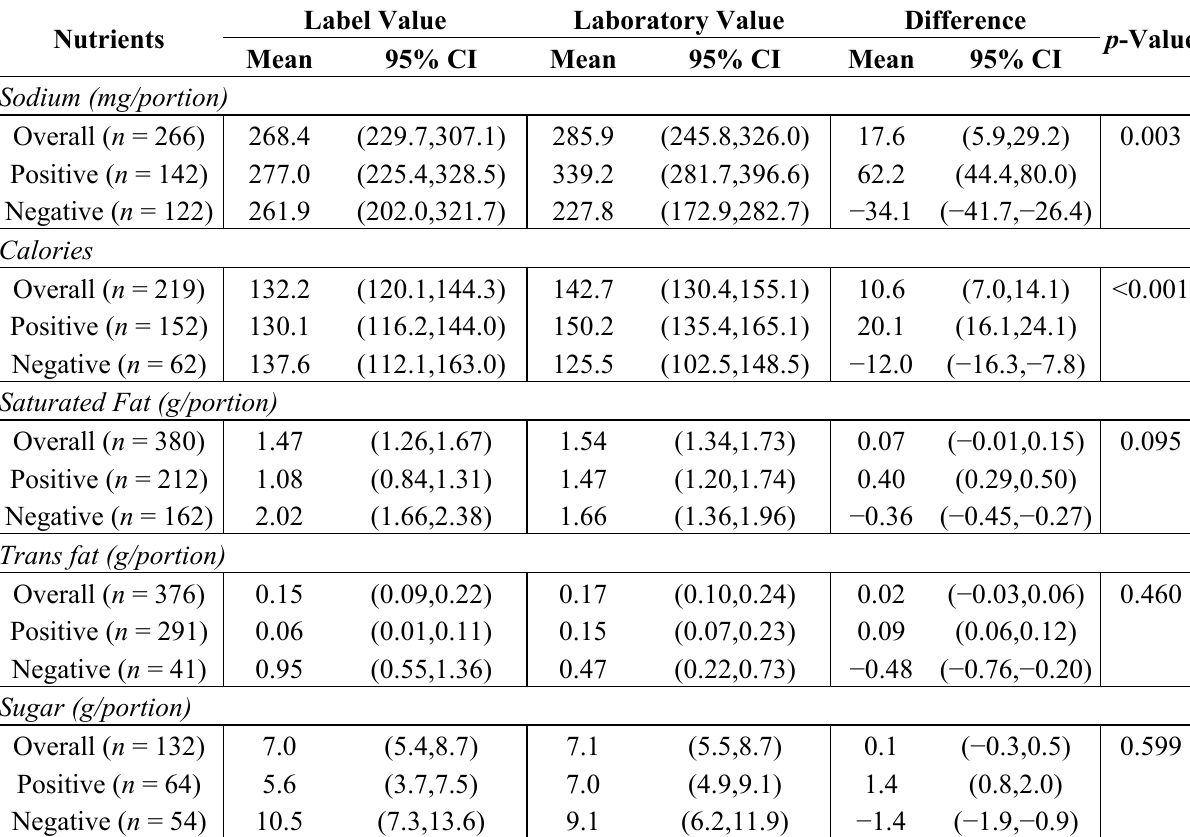
Table 3. Comparing label and laboratory values: Means and 95% confidence